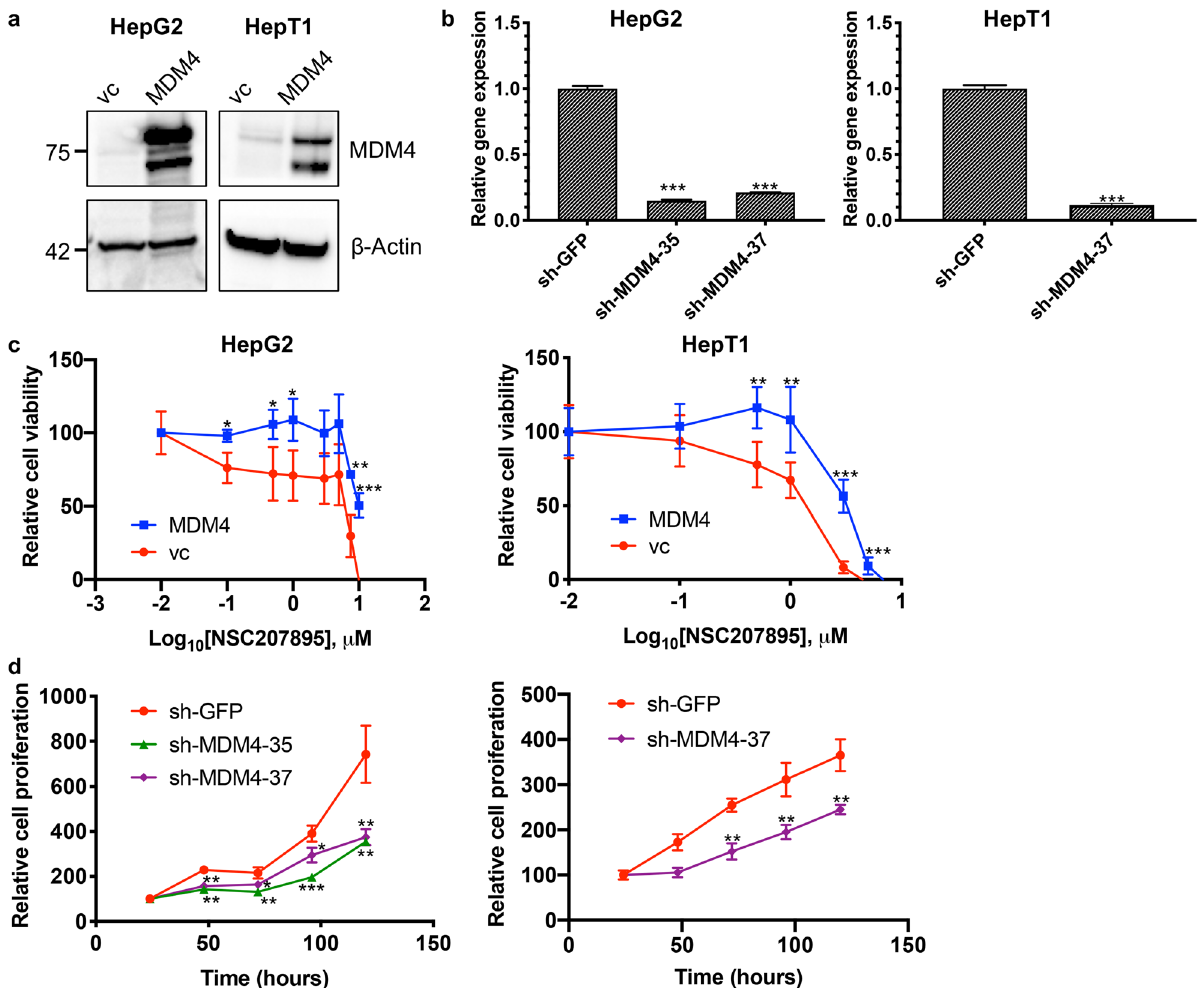
Figure 7. Cytotoxic effects of NSC207895 are dependent on MDM4. ( a ) Immunoblotting with HepG2 and HepT1 cells transduced with MDM4 cDNA or vector control (vc) with an antibody recognizing MDM4 (04–1555, Millipore). β-Actin immunoblotting was used as a loading control. Data shown are representative of at least three independent experiments. Full length blots for data shown in a are presented in Supplementary Fig. 11. ( b ) Bar graphs representing normalized mRNA expression of MDM4 analyzed with qPCR experiments. RNA extracted from HepG2 and HepT1 cells transduced with sh-MDM4-35 or sh-MDM4-37 was compared to that transduced with sh-GFP . ( c ) Cells transduced with MDM4 cDNA or vc were incubated with varying concentrations of NSC207895 for 48 h. MTT assays were performed at 48 h to asses viability. ( d ) Cells transduced with sh-MDM4 or control sh-GFP were grown for 120 h and MTT assays were done at 24 h intervals to assess cell number. Data shown in b, c, and d are representative of at least three independent experiments performed with three replicate wells each time. Error bars represent SD. Student’s t test * P < 0.05, ** P < 0.01, *** P <